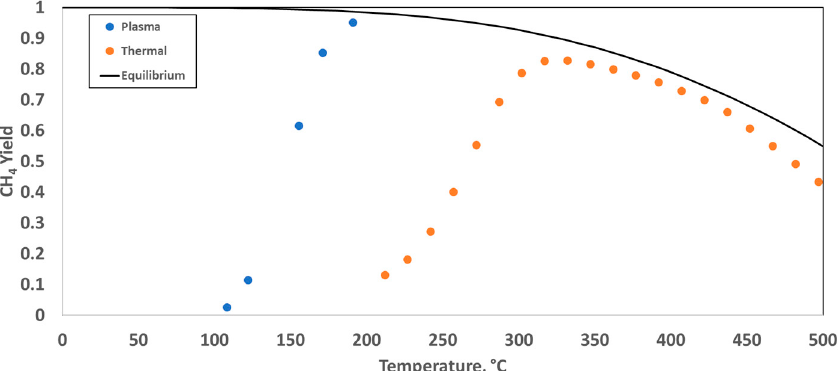
Figure 13. RuRh- γ Al 2 O 3 CH 4 yield comparison for both thermal and non-thermal-plasma-assisted tests at WHSV = 1 NL/g cat h.